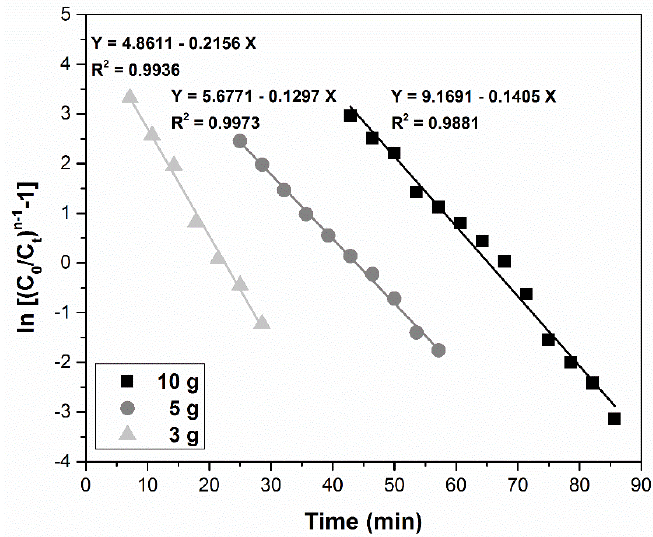
Figure 12. Clark model for the adsorption of Pd(II) in a fixed-bed column at various MgSiO3-cys amounts.